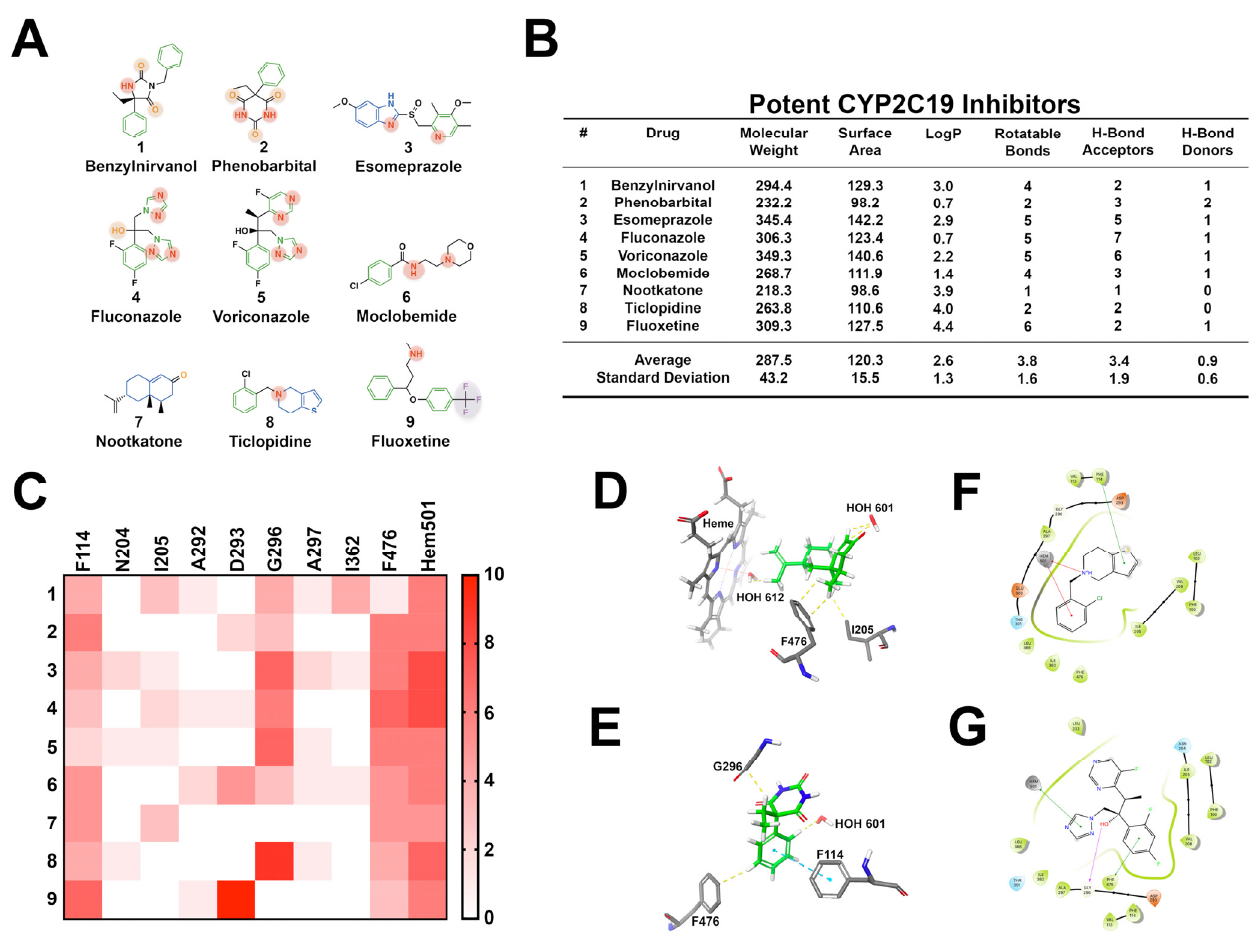
Figure 6. Structural investigation of 9 well-known high-affinity CYP2C19 inhibitors. ( A ) Common structural features seen in CYP2C19 inhibitors include aromatic moieties, heterocycles, carbonyl groups, and aromatic nitrogens. Green moieties interact with F114, F476, and/or heme; blue and red moieties interact with heme; orange interact with G296, and purple interact with water and I205. ( B ) The nine most frequently prescribed CYP2C19 inhibitors are small; however, in examining 1144 CYP219 inhibitors, the average molecule is moderately sized. ( C ) Heat map representing the frequency of ligand-to-amino acid binding interactions in the top ten most energetically favorable binding poses in docking against CYP2C19 (PDB ID: 4GQS). Key amino acids include F114, G296, F476. Frequent interactions are observed with heme-501 as well. ( D ) Three-dimensional ligand docking showing nootkatone interacting with I205, F746 and water molecules within the active site. ( E ) Three-dimensional docking image depicting phenobarbital interacting with F114, G296, F476, and water molecules within the active site. ( F ) Two-dimensional ligand interaction diagram showing the cyclic nitrogen and arylene group of ticlopidine coordinating with heme-501. ( G ) Two-dimensional interaction map showing voriconazole coordinating with heme, while simultaneously interacting with G296 and F476.